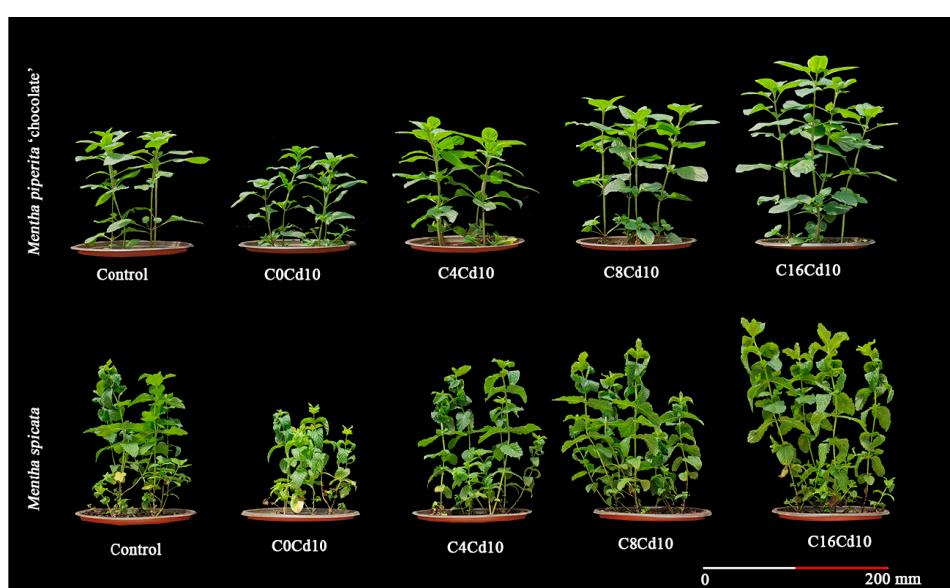
Figure 1. Effect of biochar on two mint species under Cd stress.